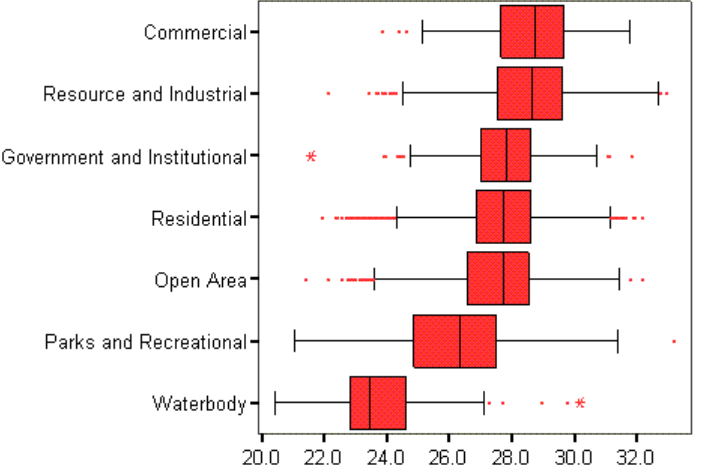
Figure 3. Boxplots of mean surface temperature by land use polygon. Land use types are sorted by decreasing average